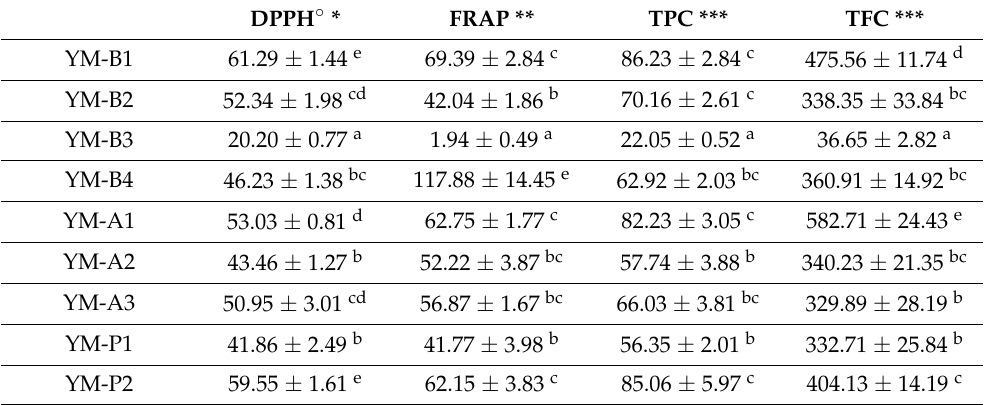
Table 4. Comparison of the total phenolic compounds and antioxidant activity of analyze yerba mate